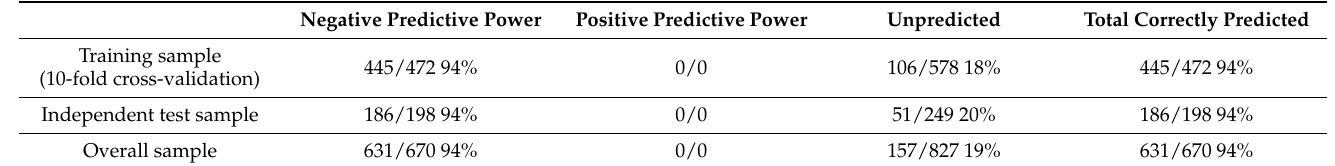
Table 3. Overview of the performance of the best neural network model in predicting dose area product. Results refer after application of the reject option and are given in the training as well as independent test sample to demonstrate its ability to generalize to new previously unseen